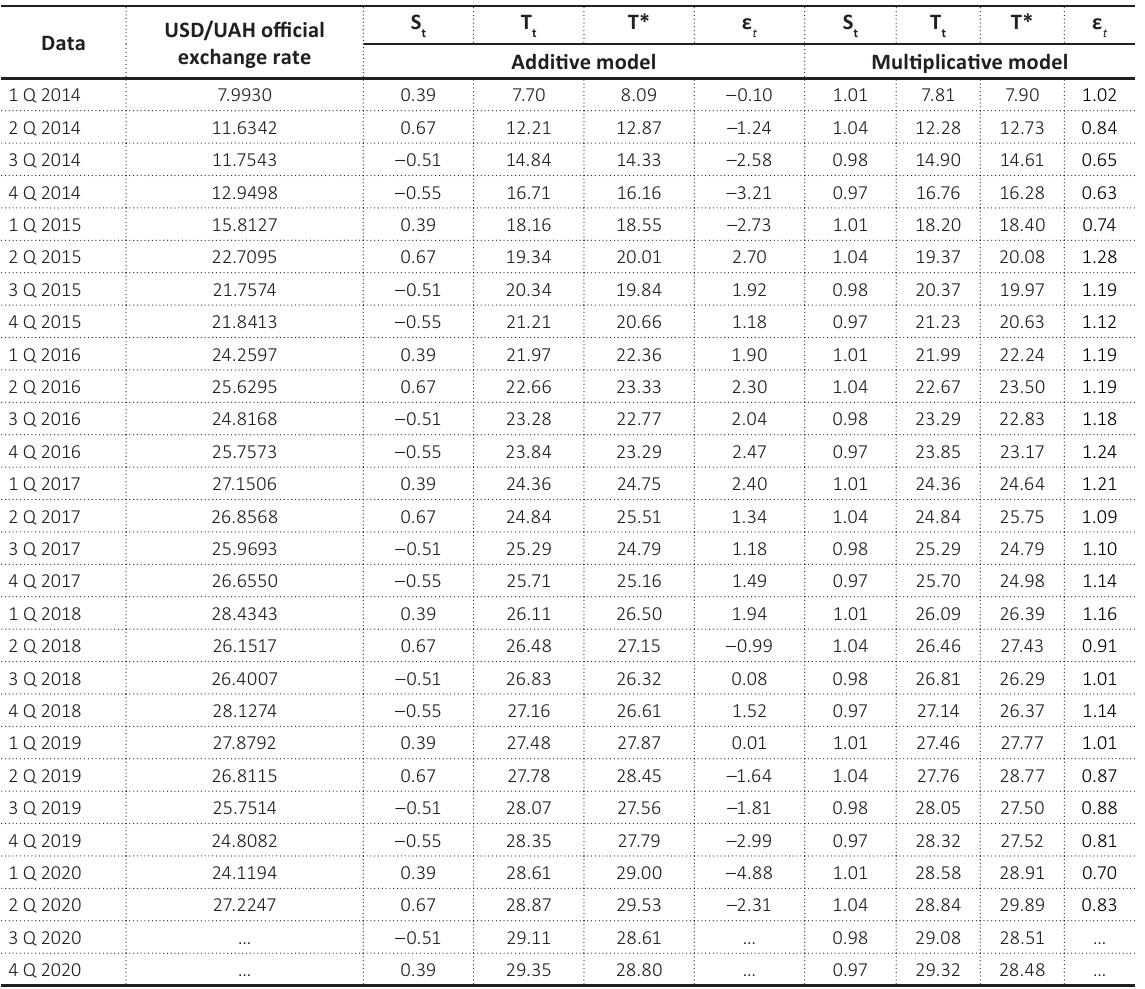
Table B2. Calculations of forecast values for additive and multiplicative models